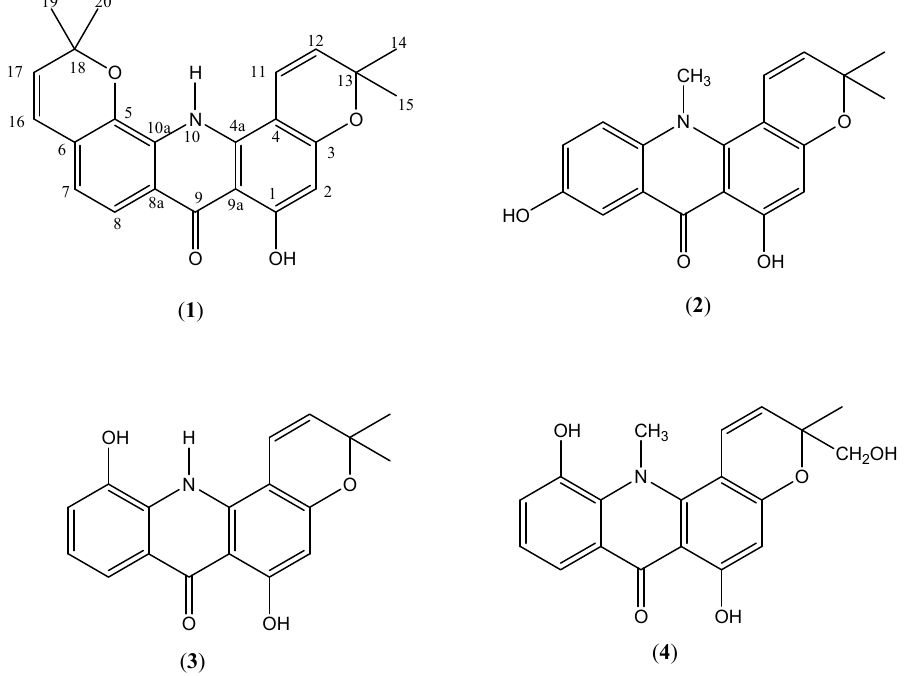
Figure 1. Structures of acridone